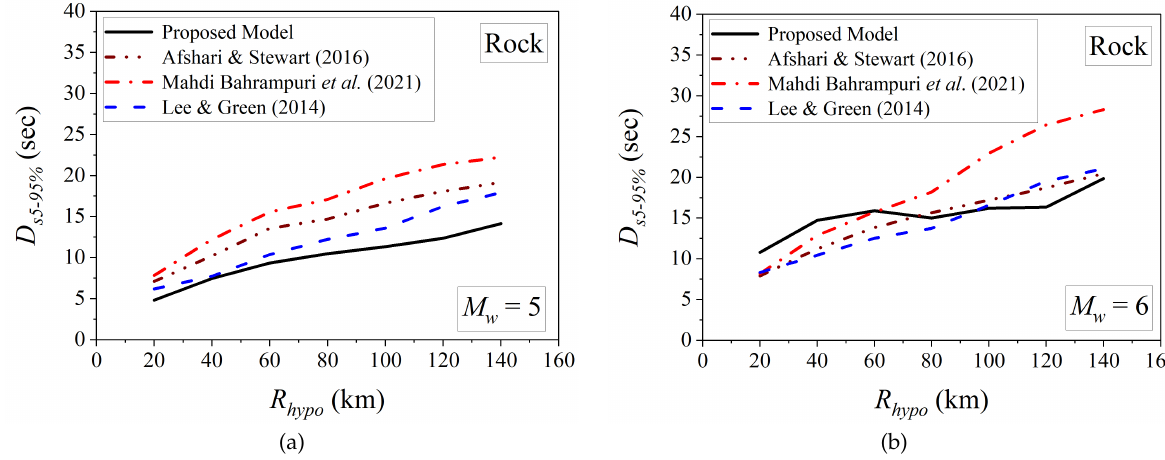
Fig. 11. Comparison of D s 5 − 95% between this study and existing models for (a) M w = 5, and (b) M w = 6.